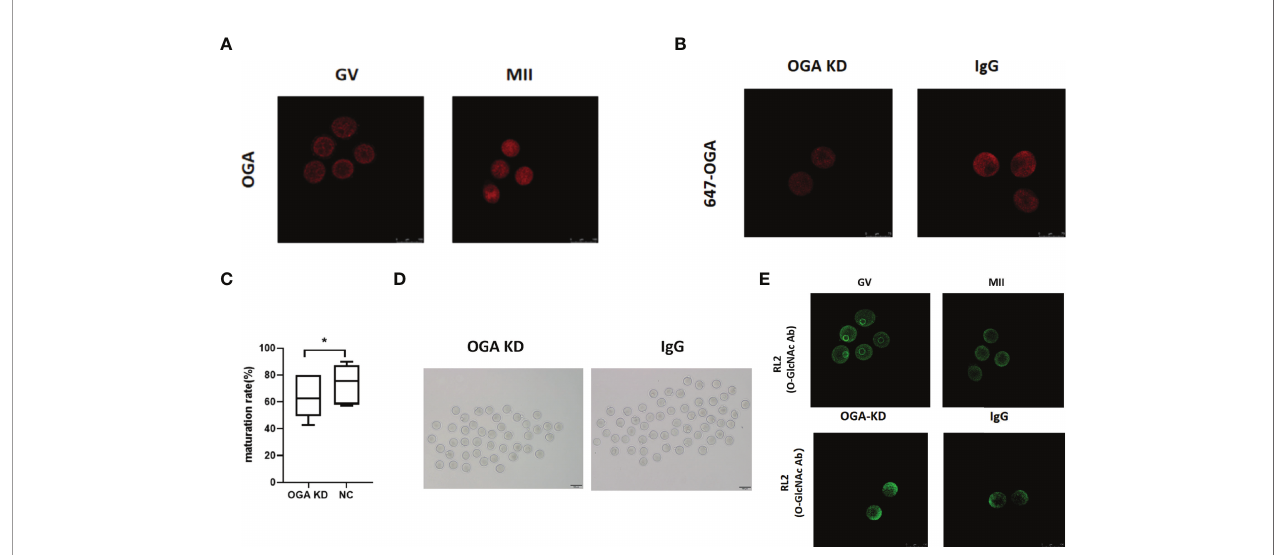
FIGURE 4 | OGA depletion retarded mouse oocyte maturation in vitro. (A) Compared with GV oocytes, OGA gene expression was upregulated in MII oocytes. (B) OGA was signi fi cantly downregulated by Trim-Away. (C) Box plot showed the difference of oocyte maturation rates between OGA KD group and the control group. (D) Representative pictures of oocyte maturation in OGA KD group and the control group. (E) Different expression of O-GlcNAc in GV and MII oocytes was veri fi ed by immuno fl uorescence, and O-GlcNAc modi fi cation was upregulated after OGA intervention. Data represent the mean ± SEM of at least three independent experiments. * P <